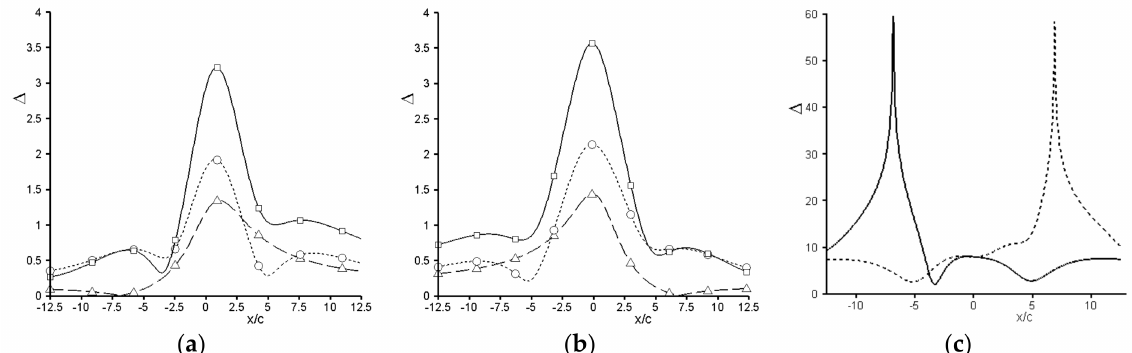
Figure 6. Low frequency ( St = 0.294) noise radiation from the trailing edge of an airfoil set at relatively high incidence ( α = 20 ◦ ). Left ( a ) and center ( b ) side, respectively: RMS pressure recorded along the top and bottom walls (depicted in linear scale, once normalized by A max ). Incident field (long dashes with delta symbols), all reflected fields (small dashes with circle symbols) and total field (solid line with square symbols). Right side ( c ): Deltas (in dB) between the incident and total RMS pressure fields, as recorded along both the top (solid lines) and bottom (dashes)